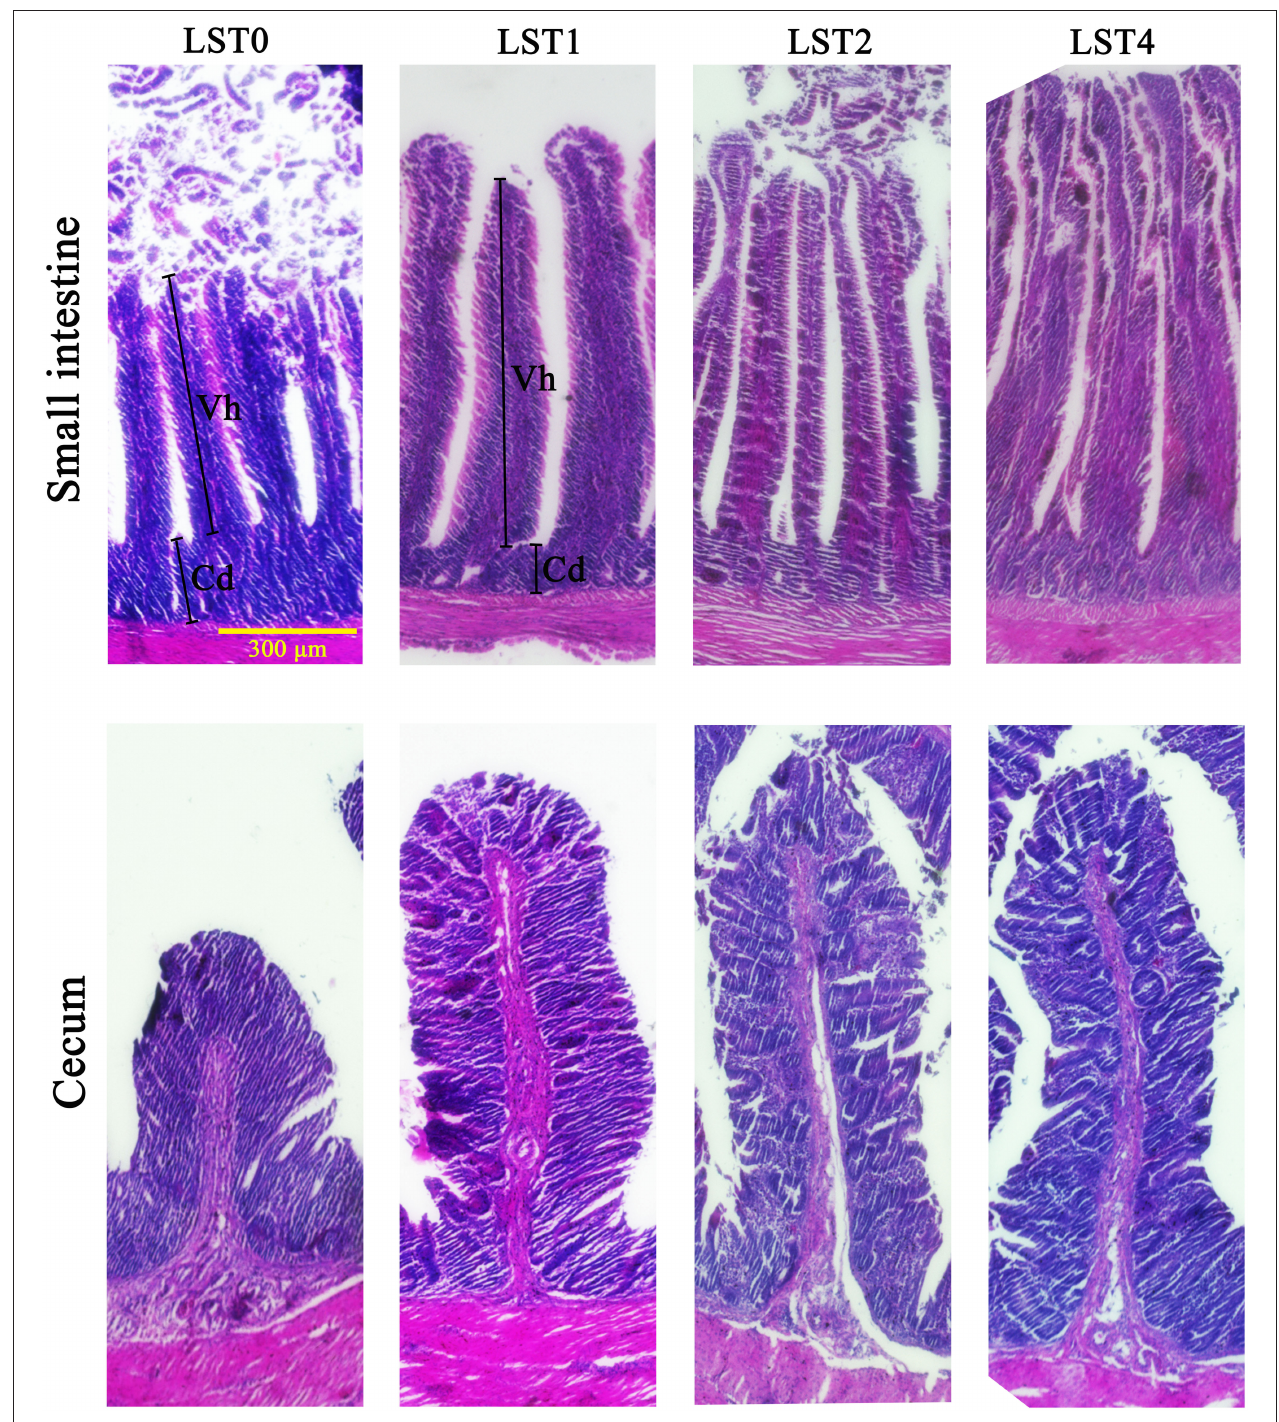
FIGURE 1 | Histomorphology of chicken small intestine (ileum) and cecum. LST, Lasia spinosa Thw.; LST0, control diet; LST1, 1% supplementation level of LST powder; LST2, 2% supplementation level of LST powder; LST4, 4% supplementation level of LST powder; Vh, villus height; Cd, crypt depth. Bar = 300 µ m. living organisms (24). The elimination of free radicals depends DNA, lipids, and proteins. Lipid peroxidation is a fundamental cellular degenerating process caused by free radicals and readily on the action of several enzymes such as SOD, GSH-Px, and CAT occurs in the tissues rich in highly oxidizable polyunsaturated (25). Moreover, chicken meat is relatively rich in polyunsaturated fatty acids, which may contribute to cell death and disease in fatty acids, making it extremely vulnerable to oxidation